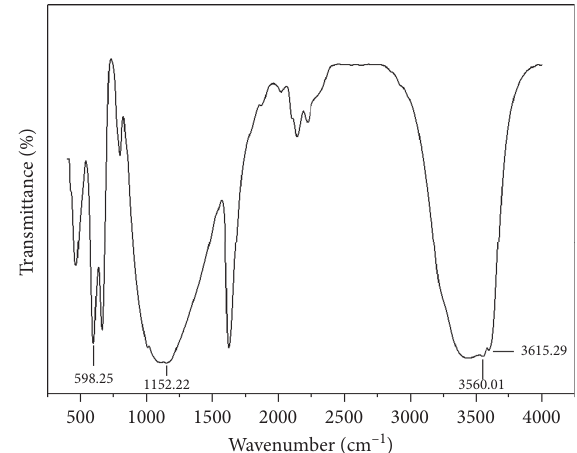
Figure 15: Fourier infrared spectrogram at a reaction time of 1.5h when the succinic acid dosage was